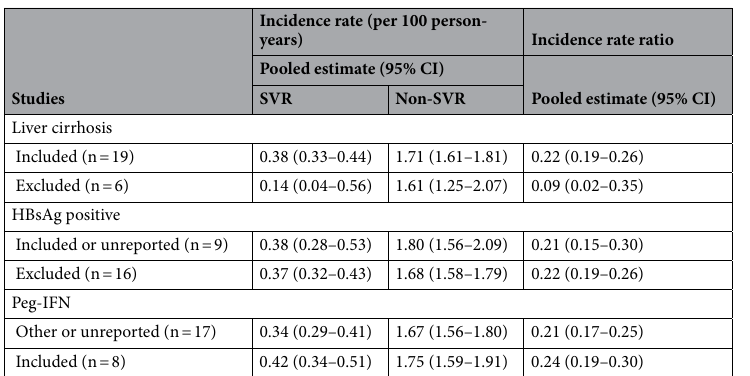
Incidence rate (per 100 person- years)